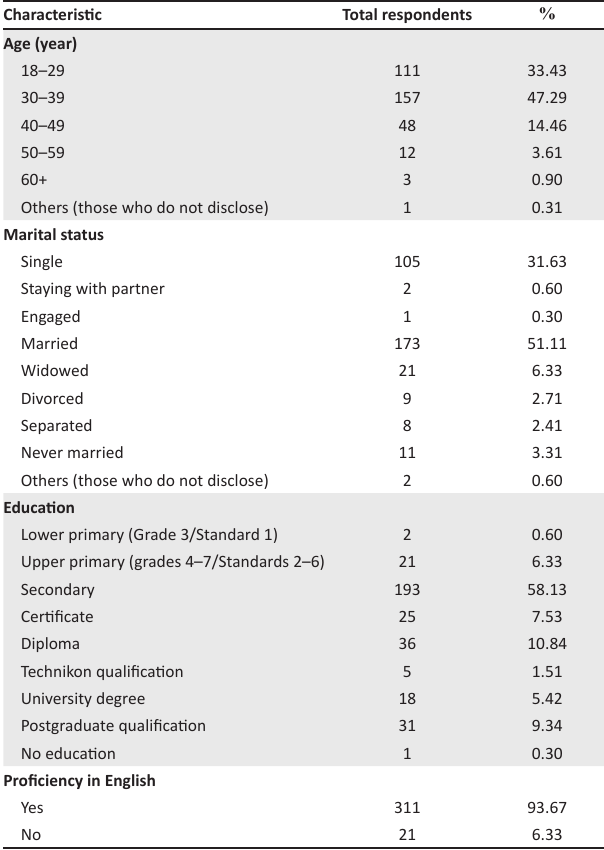
TABLE 1: Respondents’ socio-economic and demographic characteristics.